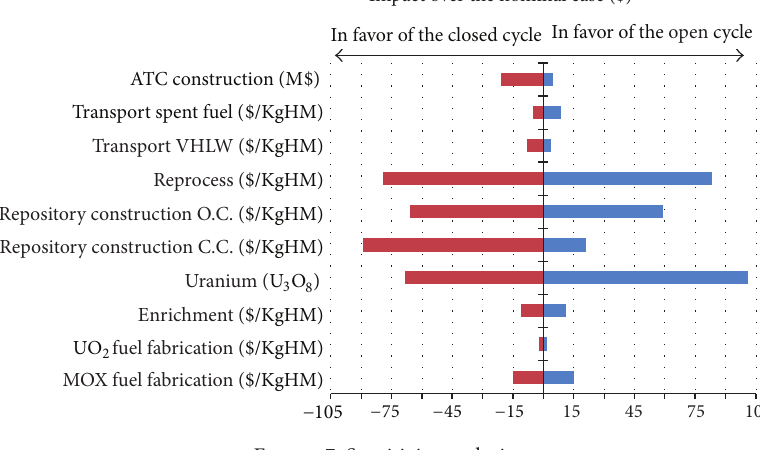
Figure 7: Sensitivity